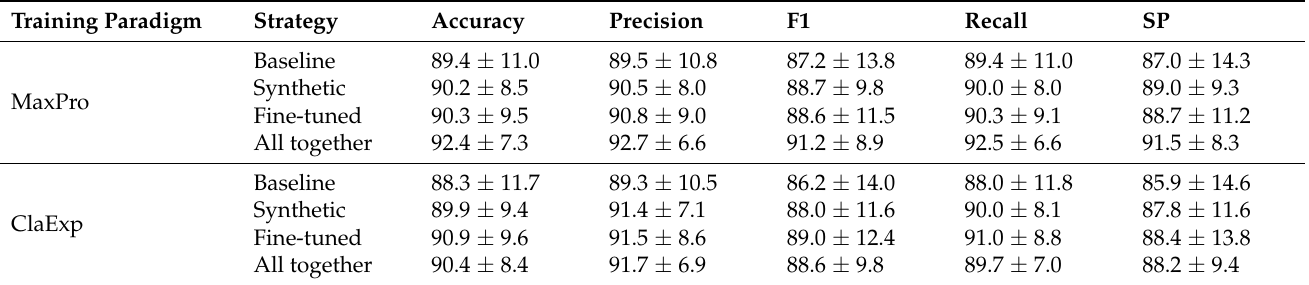
Table 7. Figures of merit for all design strategies measured from the LORO cross-validation method. Synthetic data generated with the expert WGAN.